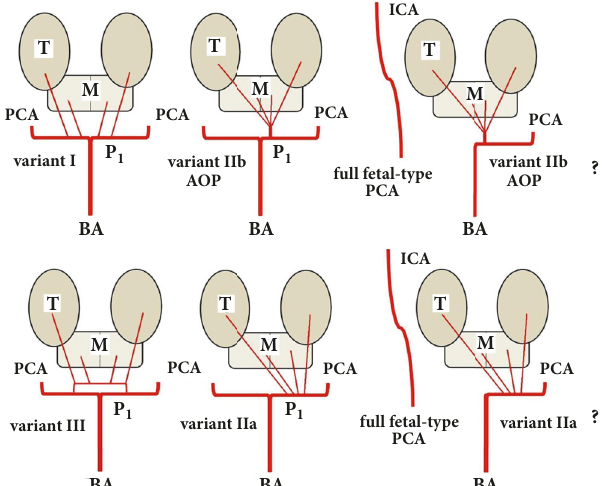
Figure2:Possiblevariationsinvolvingparamedianperforatingthalamic-mesencephalicarterialsupply(accordingtoPercheron’sdescription) [7, 8]. I . The most common: many small perforating arteries arising bilaterally, from P1. IIb . The artery of Percheron: a single (asymmetrical) common trunk, arising from one P1 arterial segment. IIa . Multiple branches emerging (asymmetrically) from one P1 arterial segment. III . An arterial arcade is bridging the P1 segment of both PCAs, and the perforating arteries are arising from this arterial shunt. The actual case report : uncommon association of full fetal-type PCA (originating directly from the internal carotid artery) with Percheron’s arterial variant. It was not possible to specify the particular anatomical arterial disposal (type IIb or IIa). (T, thalamus; M, mesencephalon; BA, basilar artery; PCA, posterior cerebral artery; P1, first arterial segment of the PCA; AOP, artery of Percheron; ICA, internal carotid artery.)